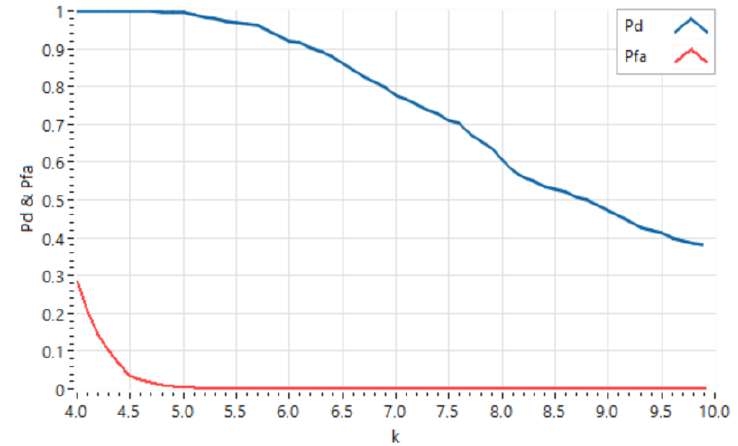
Figure 7. Global Detection Probability and False Alarm Probability of the system.